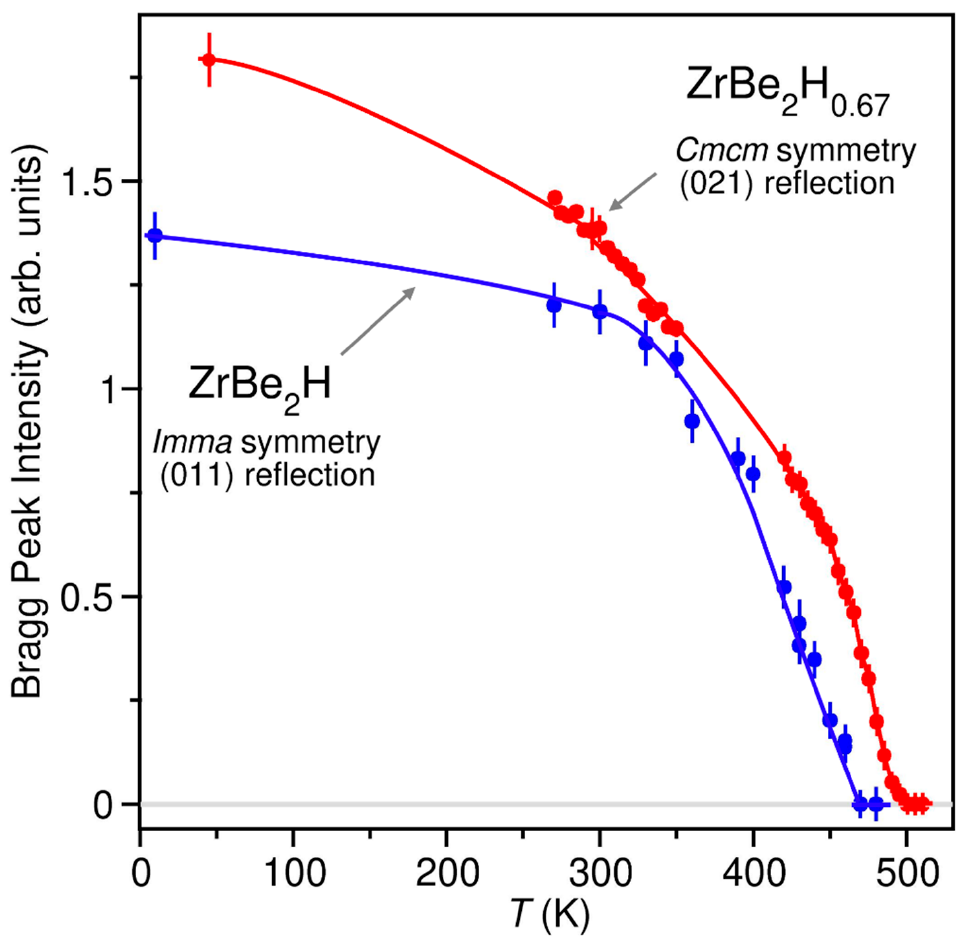
Figure 3. Temperature progression of the intensities of the respective (011) and (021) Bragg peaks for orthorhombic ordered ZrBe 2 H and ZrBe 2 H 0.67 . These respective peaks correspond to the low-angle features seen near 2 θ = 19.1 ◦ and 16.3 ◦ in the BT-1 Powder Diffractometer patterns at λ = 1.5391 Å and are absent for P 6/ mmm symmetry. The majority of the data were collected on the BT-4 Triple-Axis Spectrometer at λ = 2.3578 Å (ZrBe 2 H) and λ = 1.5288 Å (ZrBe 2 H 0.67 ). Relative intensities for each curve are arbitrarily scaled for clarity. Lines are drawn through the data as guides to the eye. The more extensive temperature-dependent NPD data collected for the ZrBe 2 H 1.2